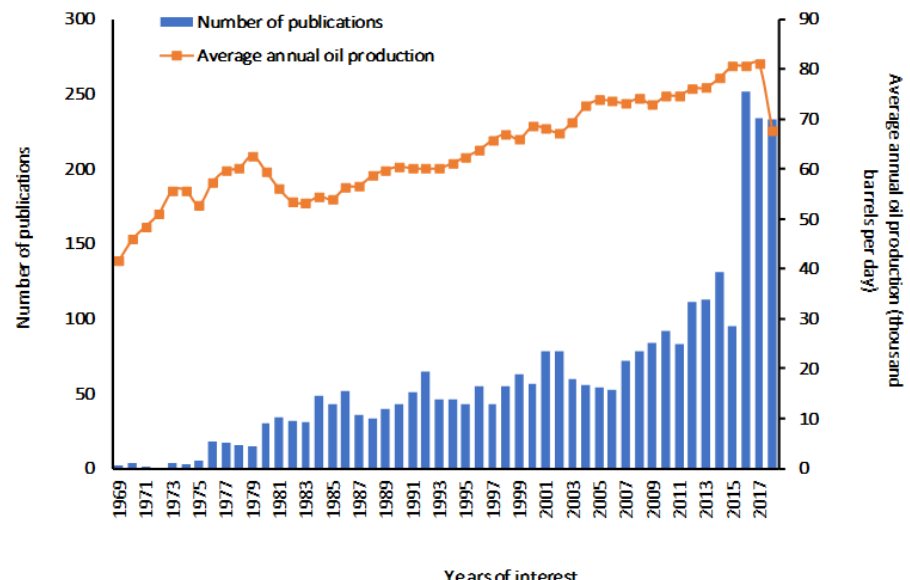
Figure 1. The average annual crude oil production and interest in sulfolane during the last five decades (from 1969 to 2018). Plot of the number of papers, where ‘sulfolane’ was searched in the paper title or abstract and the average annual oil production (thousand barrels/day) based on Reaxys and EIA data